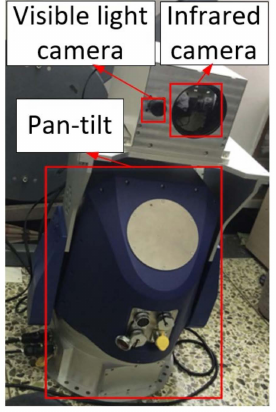
Figure 7. Multi-sensor coaxial rotation system.